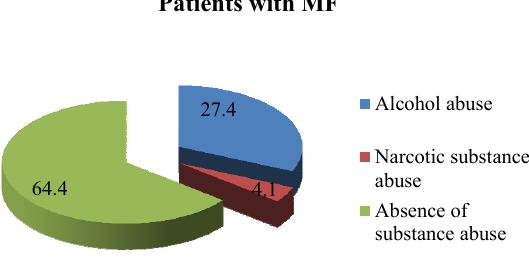
Fig. 1. Frequency of substance abuse in patients with delayed union of MF Correlation between general and local factors and delayed union of MF